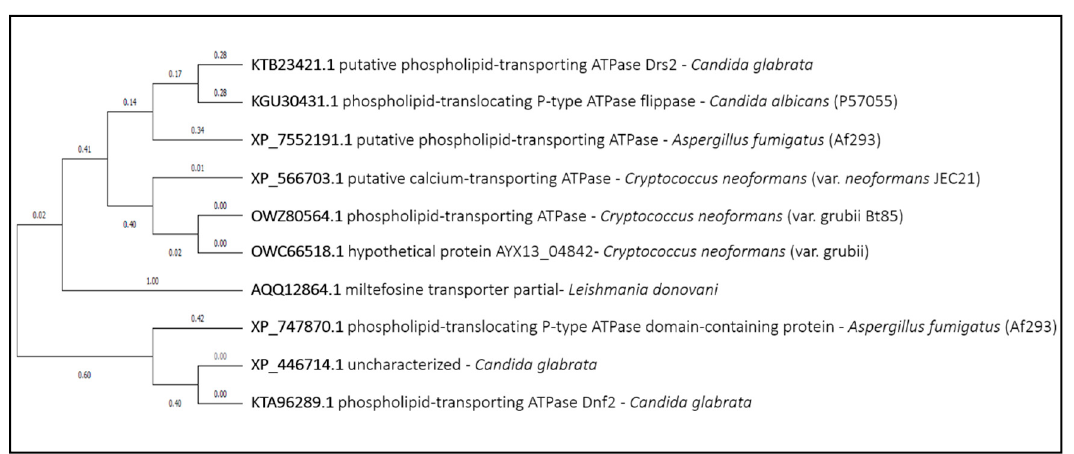
Figure 10. Miltefosine transporter phylogenetic analysis. The tree with the highest log likelihood is shown. This analysis involved 10 amino acid sequences. There were a total of 1645 positions in the final dataset. Evolutionary analyses were conducted in MEGA X.